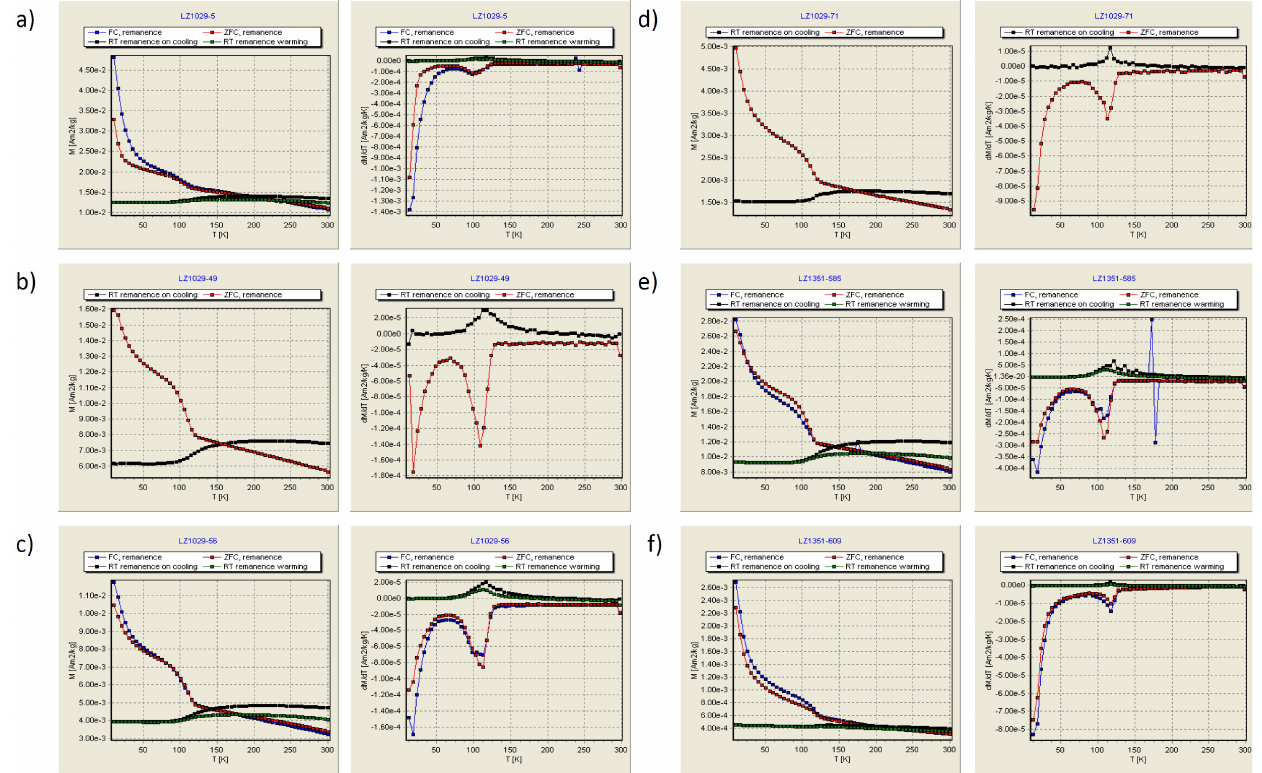
Fig. 8. A selection of MPMS graphs from LZ1029 and PG1351. Left-hand columns show original graphs from MPMS measurements. Right- hand columns show the derivatives of the left graphs to better indicate changes in slope between 10 and 35K, indicating the presence of room-temperature paramagnetic minerals vivianite and siderite (or rhodochrosite), which become magnetic at about 12 and 32K, respectively. Samples from LZ1029 were from depths of (a) 5cm, (b) 49cm, (c) 56cm, and (d) 71cm. Samples from PG1351 were from depths of (e) 585cm and (f)